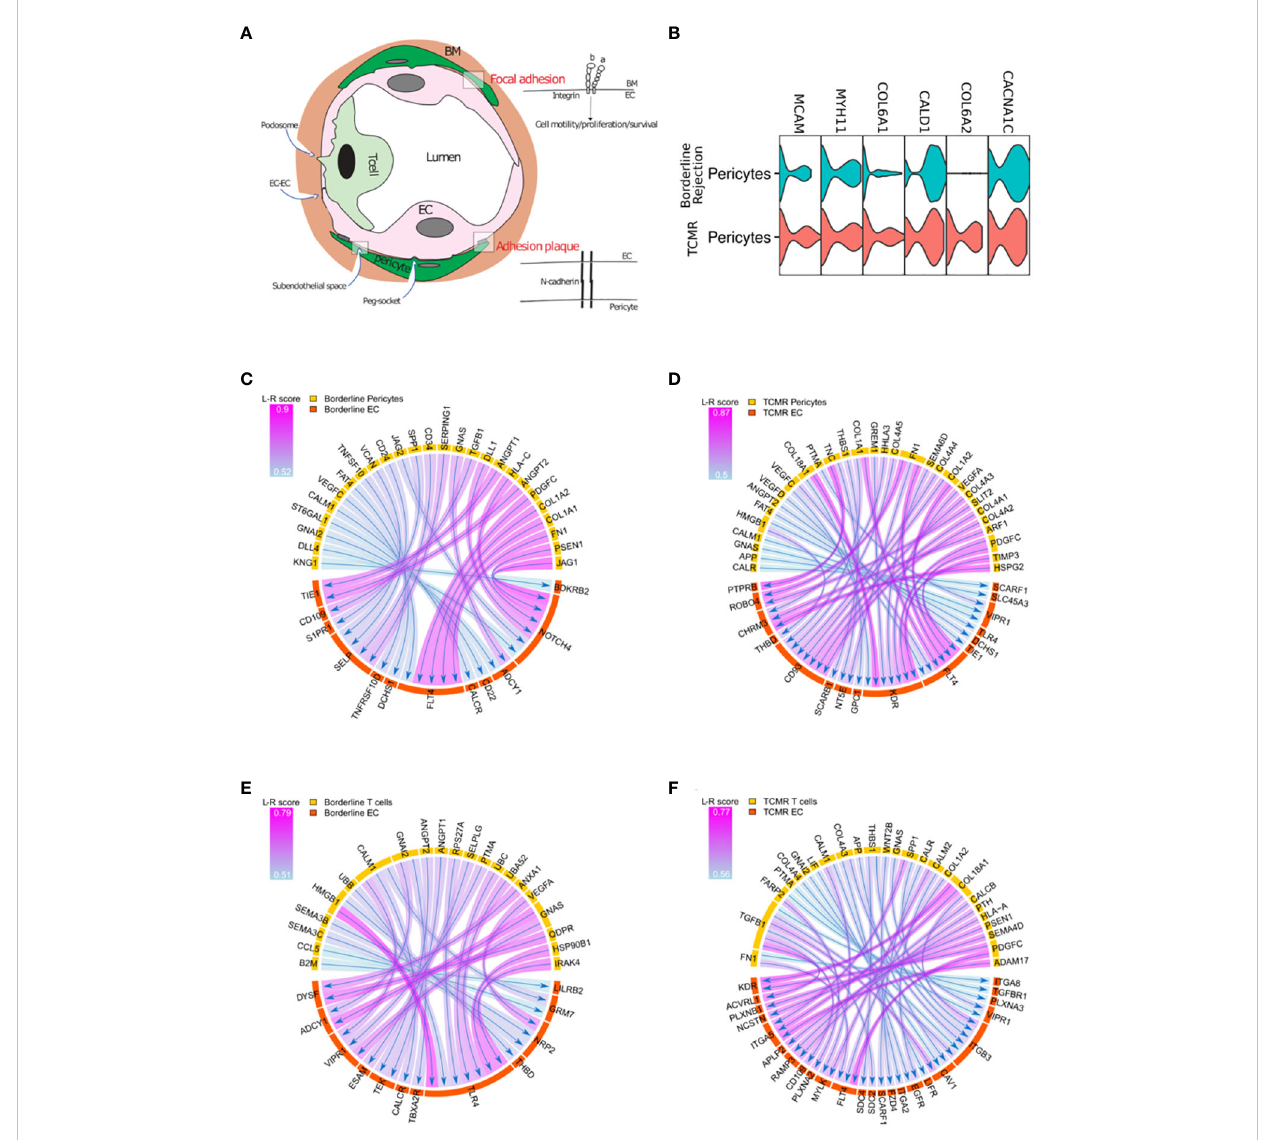
FIGURE 4 (A) T-cells, endothelial cells (EC), and pericytes interactions. Focal adhesion represents the interaction between ECs and the surrounding basement membrane (BM); adhesion plaque is the interaction between ECs and pericytes. (B) Violin plot showing canonical markers expressed by pericyte clusters in borderline and TCMR. (C, D) Circos plot showing the ligand-receptor interactions between pericytes in yellow and endothelial cells in orange in borderline and TCMR; the heads of arrows are toward the receptor side; the halo color around the arrow represents the strength of this interaction as per L-R score. (E, F) Circos plot showing the ligand-receptor interactions between T-cells in yellow and endothelial cells in orange in borderline and TCMR; the heads of arrows are toward the receptor side; the halo color around the arrow represents the strength of this interaction as per L-R